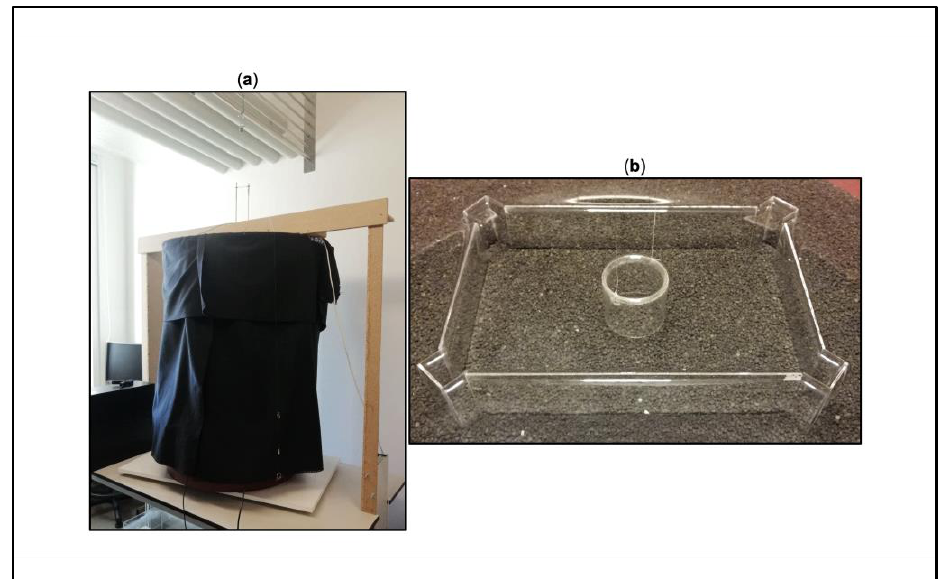
Figure 1. Experimental apparatus. ( a ) Setup from the outside. ( b ) Rectangular transparent arena with upright corridors at the corners. The transparent cylinder hosting the experimental fish at the beginning of each training trial is also shown (credit by Sara Boffelli).